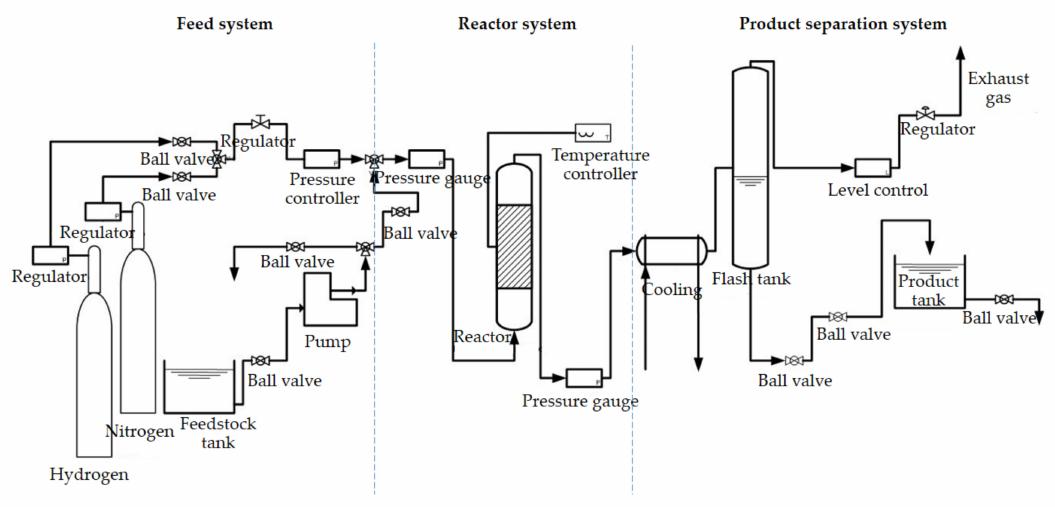
Figure 2. Diagram of high pressure packed bed reactor (HPPBR).